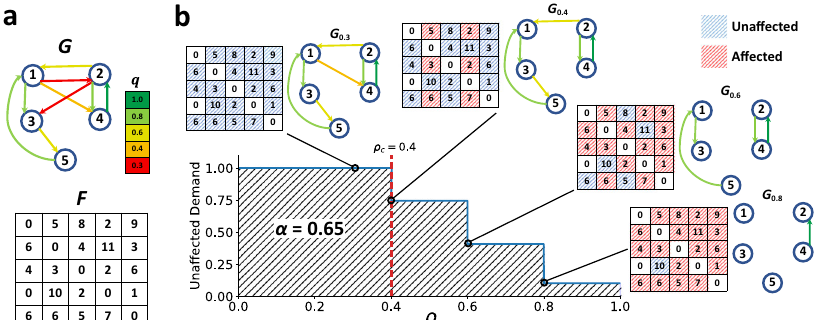
Fig. 1 Percolation on an example demand-serving network. a Network G with size n = 5, where quality q ij of each link e ij is color-coded (according to the color-bar). Matrix F quanti fi es the fl ow demand between all pairs of nodes which sums up to 100 units in total. b The percolation process is simulated by increasing a threshold ρ while removing links e ij with q ij ≤ ρ . Subnetwork G ρ is visualized at different ρ ’ s with its corresponding affected (red) and unaffected (blue) fl ow demand color-coded in matrix F . In this example, by de fi nition, the system collapses at ρ c = 0.4, when the 5-nodes strongly connected GC disintegrates into two strongly connected components of sizes 2 and 3, while unaffected demand (UD) is still at 75%. The reliability of the network G is α = 0.65, found by calculating the area under the curve of UD versus ρ